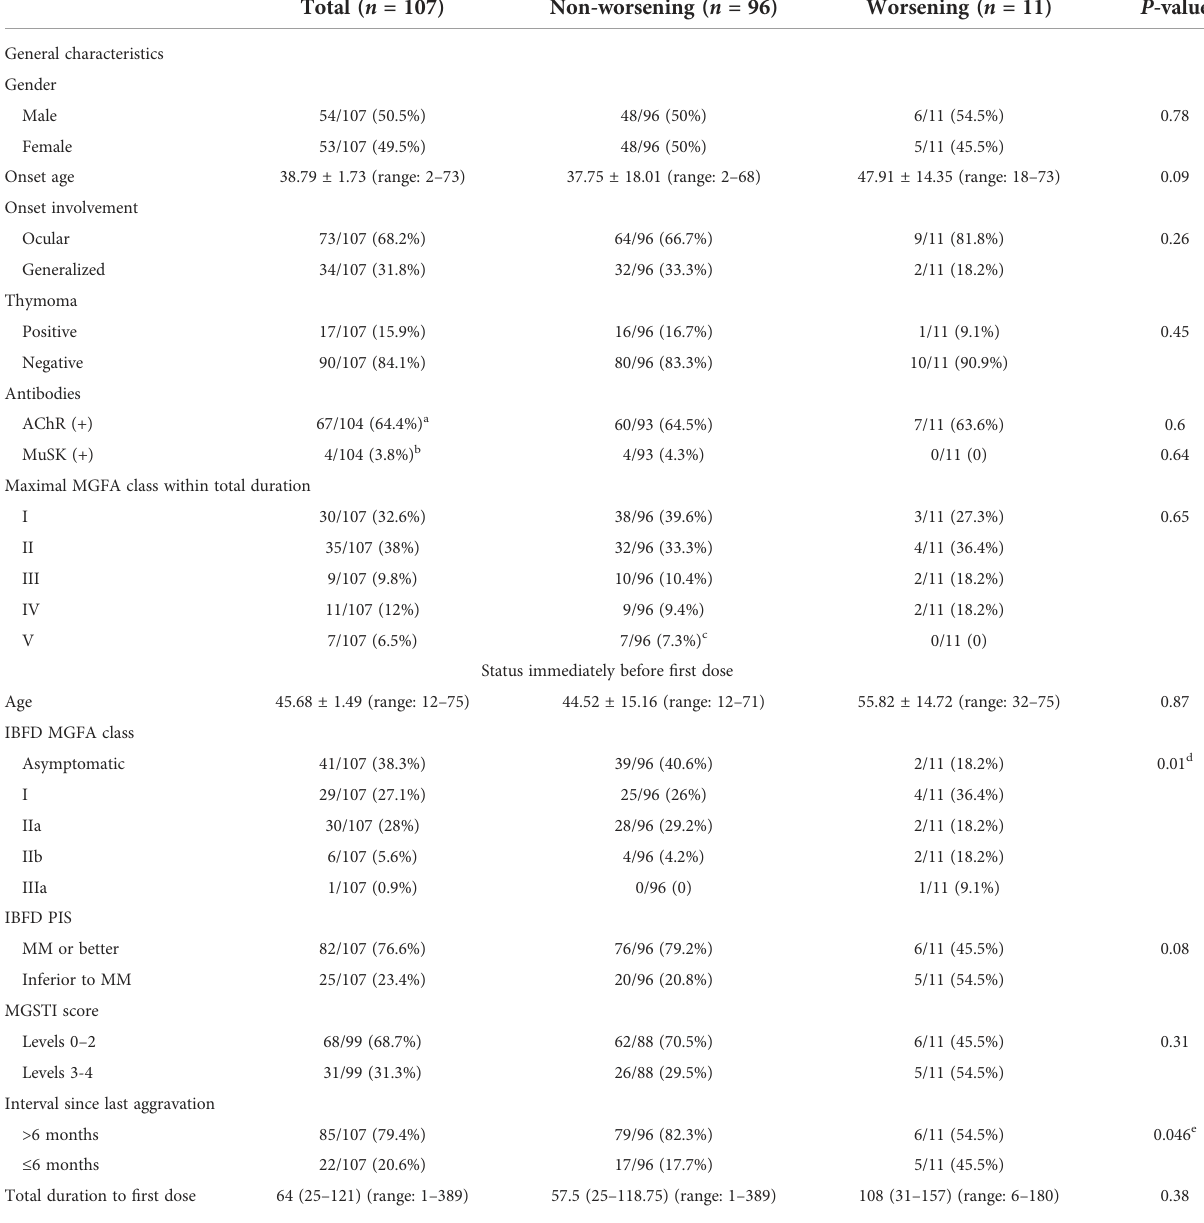
TABLE 1 Comparison between non-worsening and worsening